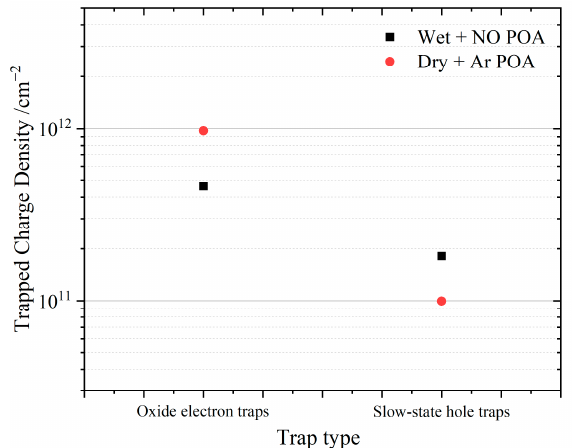
Figure 8. Extracted oxide electron traps and slow-state hole traps for both the samples.